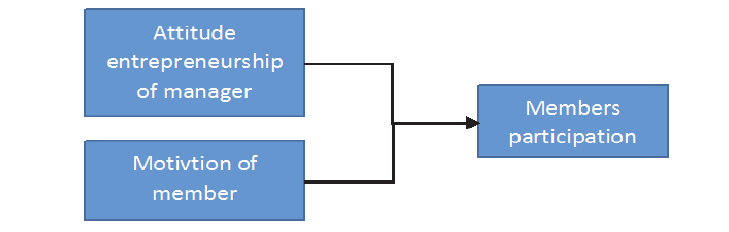
Fig. 1. Theoretical